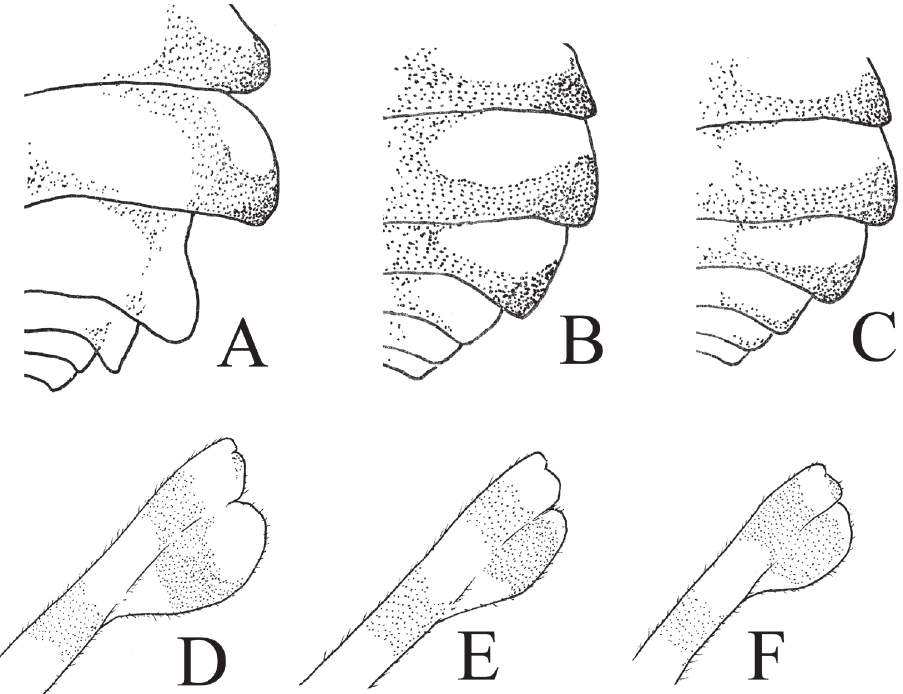
Figure 9. Abdomen and posteroventral metafemoral lobe of female Theopropus spp. A, D T. xishiae